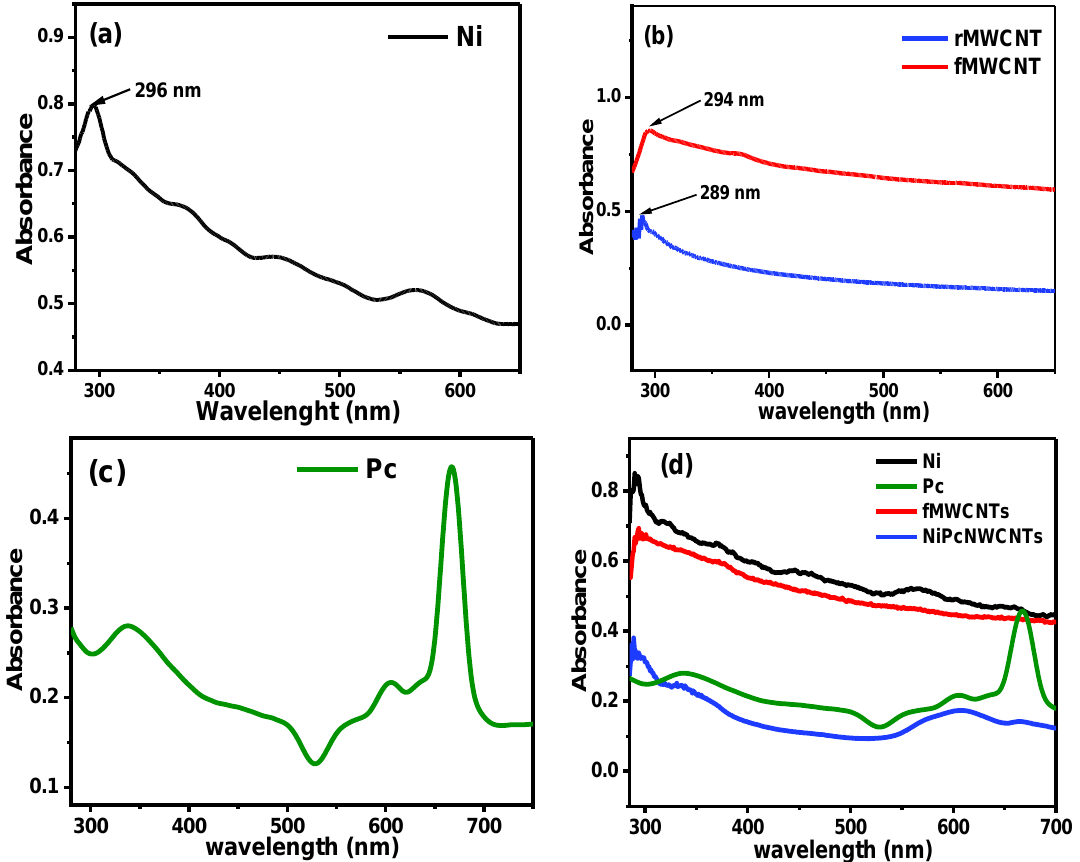
Figure 4. UV – vis spectra for ( a ) NiNp, ( b ) rMWCNTs and fMWCNTs, ( c ) Pc, and ( d ) comparative spectrum for NiNp, Pc, fMWCNTs, and NiPcMWCNTs nanocomposite.